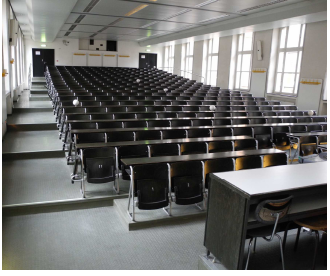
Figure 3. RGB image of the observed indoor scene.